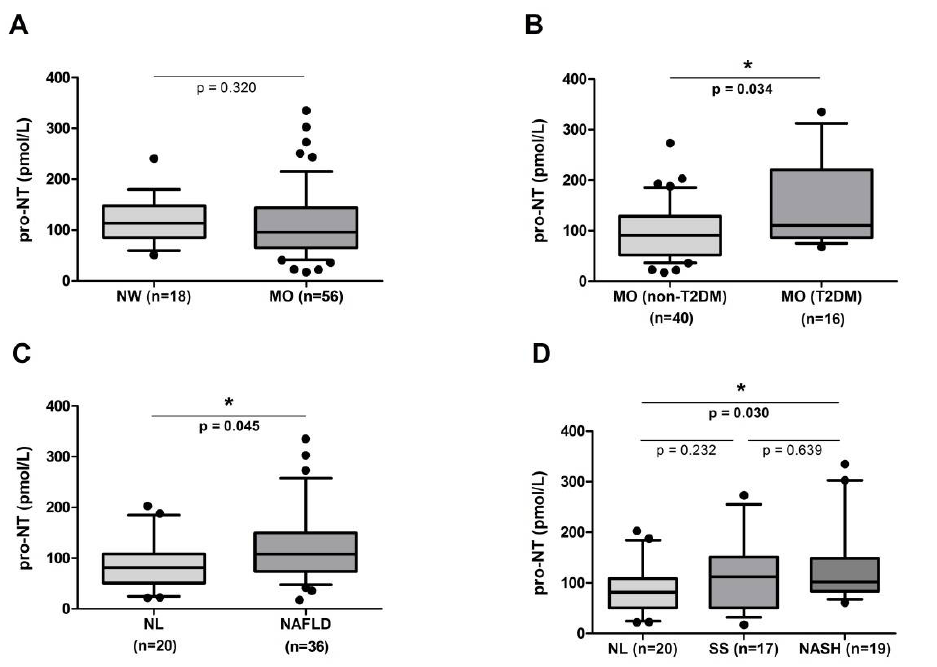
Figure 1. ( A ) Serum levels of pro-NT in women with NW and women with MO. ( B ) Serum levels of pro-NT in diabetic women with MO and non-diabetic women with MO. ( C ) Serum levels of pro-NT in women with MO and NL vs. NAFLD. ( D ) Serum levels of pro-NT in women with MO and NL vs. SS vs. NASH. NW, normal weight; MO, morbid obesity; NL; normal liver; NAFLD, nonalcoholic fatty liver disease; SS, simple steatosis; NASH, nonalcoholic steatohepatitis. * p < 0.05 is considered statistically significant.